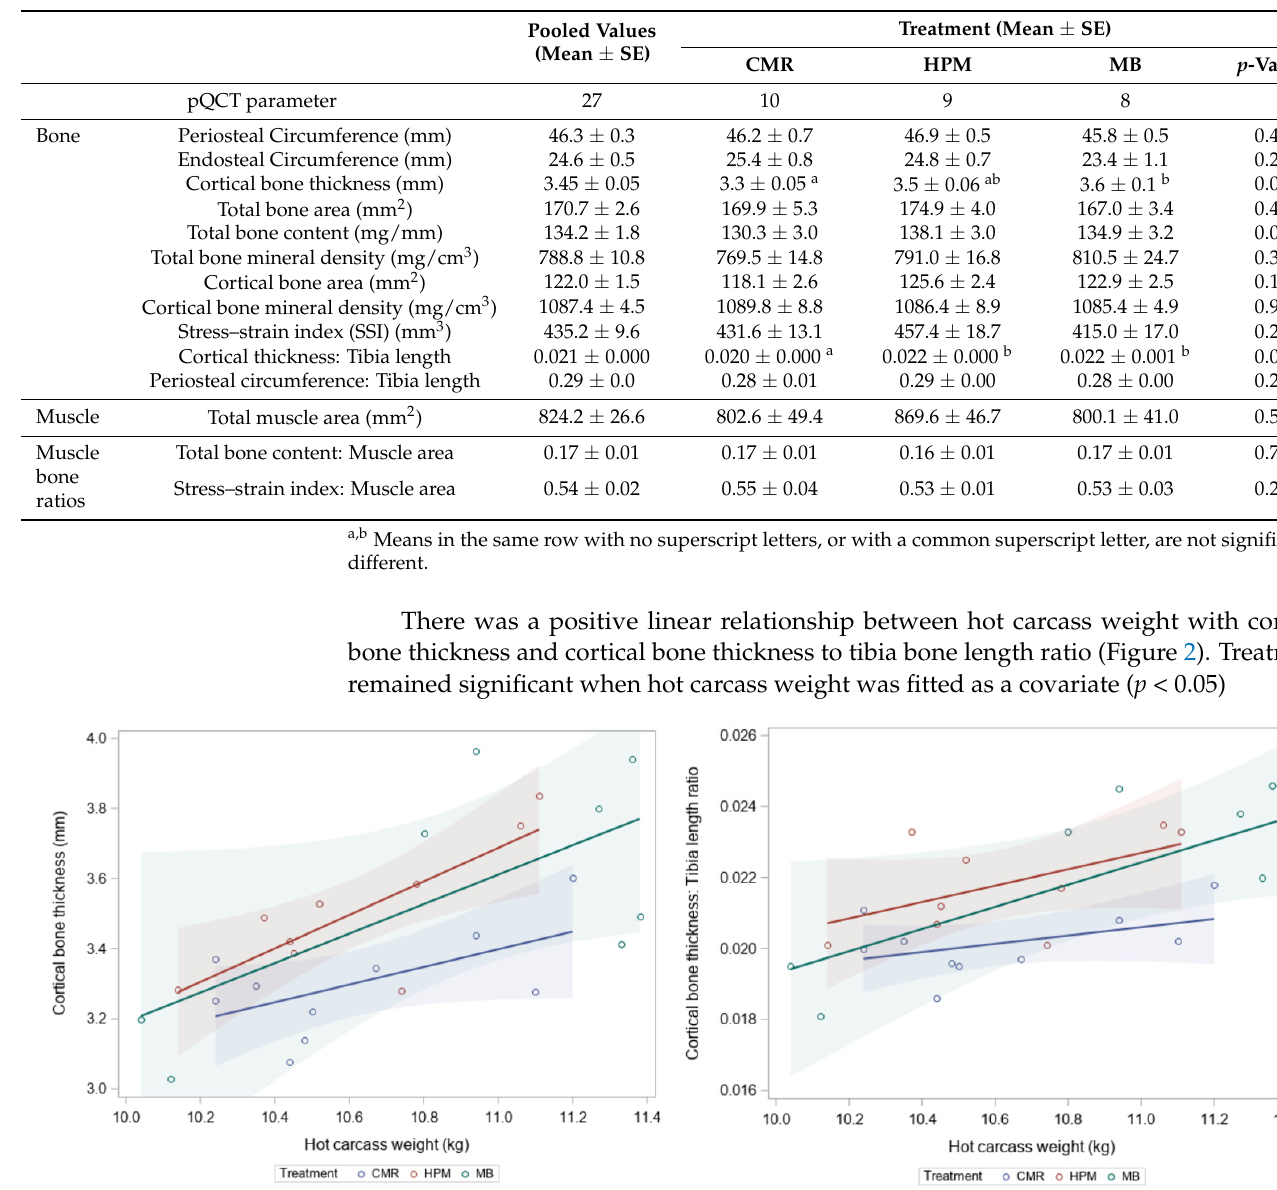
Table 2. The peripheral quantitative computed tomography parameters at the mid-diaphyseal site of the tibia for lambs fed milk replacers with variable crude protein to metabolizable energy ratio (mean ± SE, commercial milk replacer (CMR), high protein milk (HPM), milk blend (MB)) and slaughtered at 22 kg live weight.